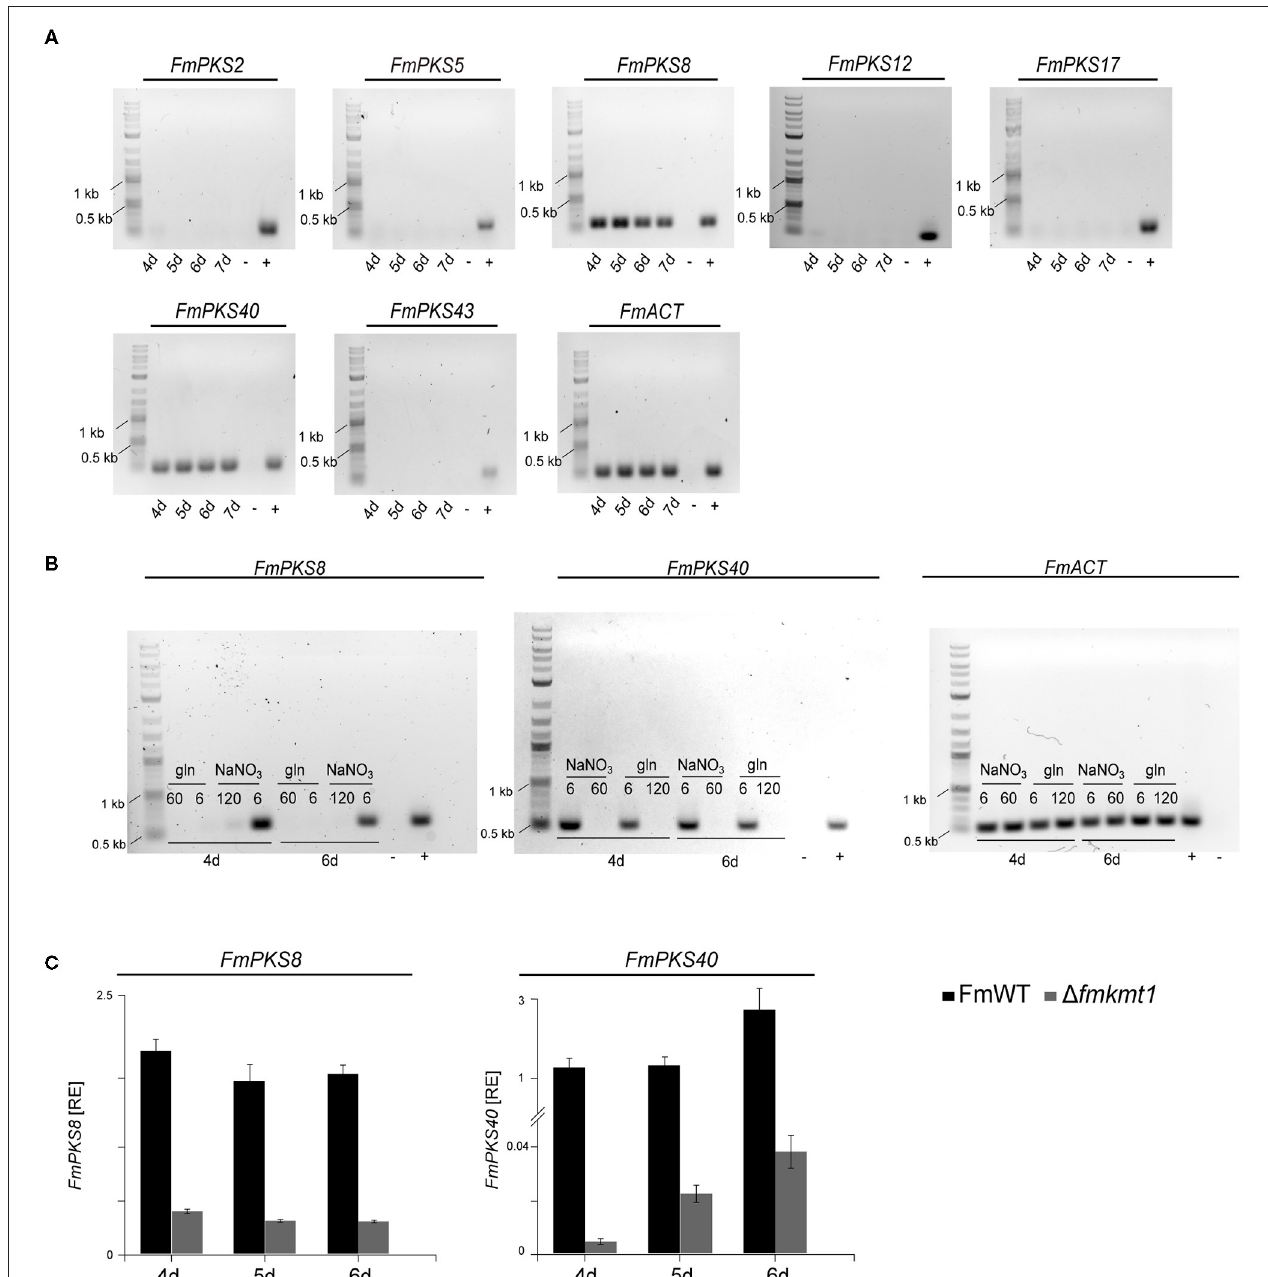
FIGURE 6 | Expressional analysis of fusapyrone (FPY) and deoxyfusapyrone (dFPY) candidate genes in F. mangiferae . (A) Semi-quantitative PCR of candidate PKS genes for FPY and dFPY production. F. mangiferae (FmWT) was cultivated for 4–7 days in FPY-inducing media and subsequently RNA was extracted from lyophilized mycelia und transcribed to cDNA. Primer used for the detection of gene expression are listed in Supplementary Table 1 . (B) Semi-quantitative PCR of gene expression in liquid ICI supplemented with different N-sources. FmWT was cultivated for 4 and 6 days in FPY-inducing [additionally 6mM glutamine (gln)] and FPY-repressing conditions. Extracted RNA was then transcribed to cDNA for semi-quantitative PCR reaction. Primer pairs used for FmPKS8 and FmPKS40 expressional analysis are listed in Supplementary Table 1 . (C) For the comparison of transcription levels, FmWT and 1 fmkmt1 were cultivated for 4–6 days in FPY inducing conditions. From lyophilized mycelium RNA was extracted and cDNA synthesized. Expression levels of FmPKS8 and FmPKS40 were measured via RT - qPCR. Mean values and standard deviations are shown. RE, relative normalized expression. For cDNA control actin was amplified using the primers Actin_F//R. As size marker GeneRuler 1kb Plus DNA Ladder (NEB) was used. As positive control ( + ) FmWT gDNA was used, while as negative control (-) sterile water was used.